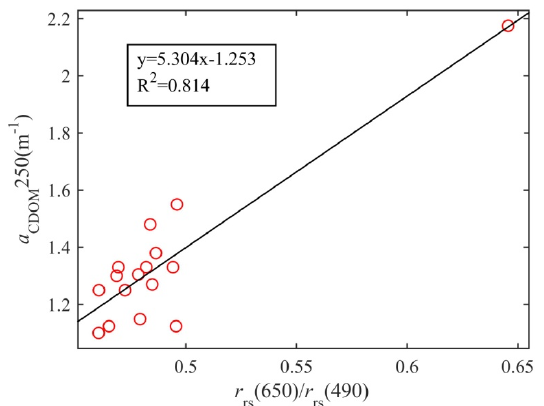
Figure A3. a CDOM at 250 nm versus the ratio of r rs (650) to r rs (490).